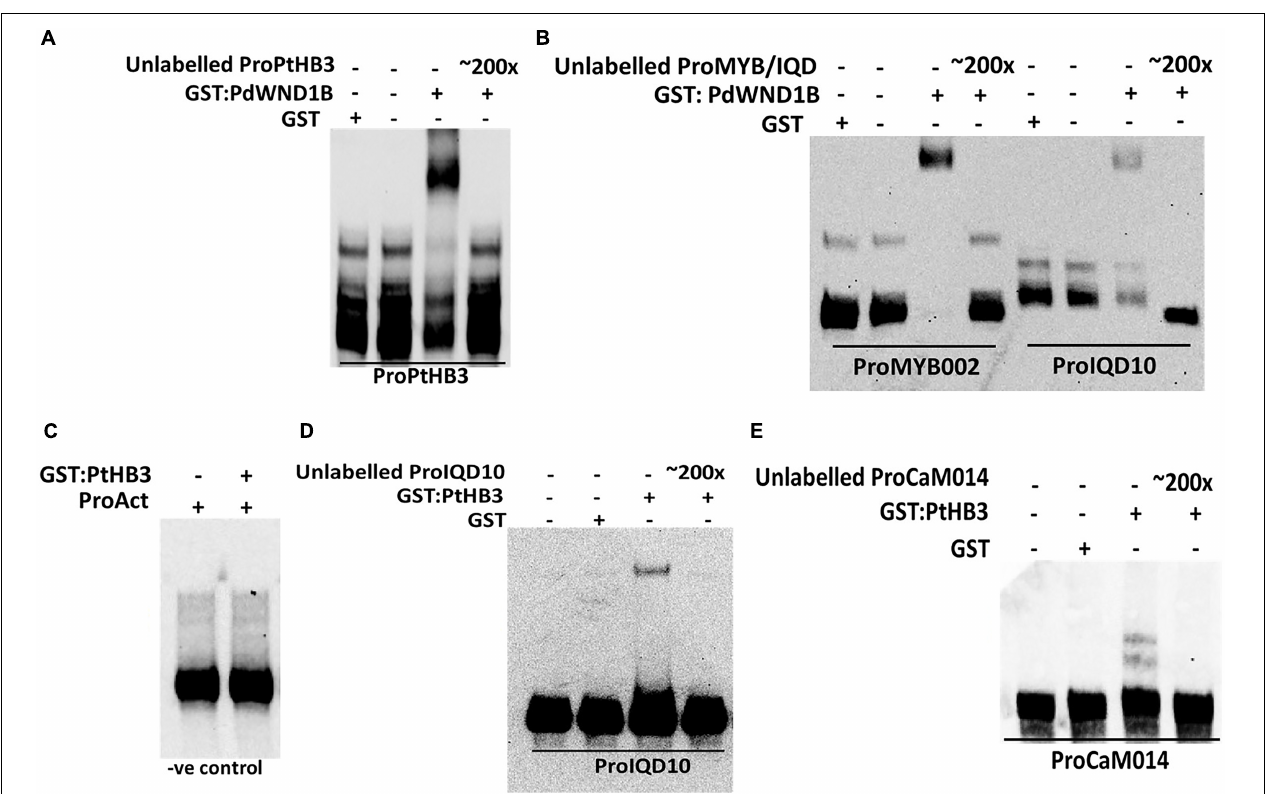
FIGURE 5 | Electrophoretic Mobility Shift assays. GST fused protein of PdWND1B binds to the promoters of (A) PdHB3 and (B) Myb002 and IQD10. GST fused PdHB3 protein binds to the promoters of (D) PdIQD10 and (E) CaM014 but not to (C) Actin, suggesting a gene regulatory network downstream of PdWND1B. Promoter regions corresponding to the 250 bp upstream of the transcriptional start site of the respective genes were used for biotin labeling and shift experiments.